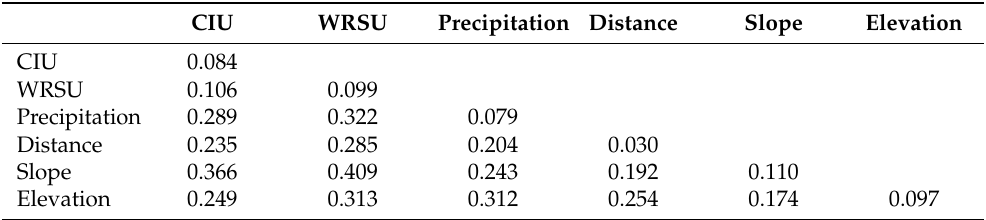
Table 7. Factor interaction detection results of constructed land distribution. CIU WRSU